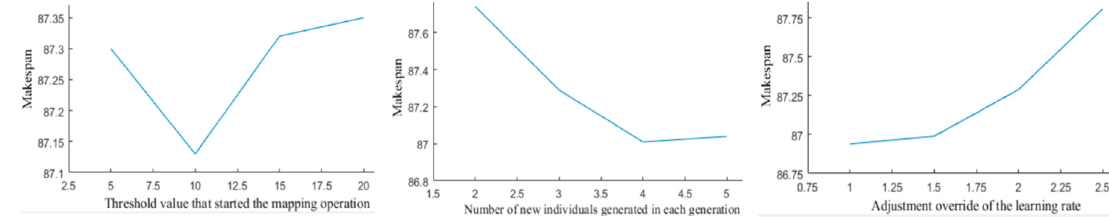
Figure 3. Trend chart of the algorithm’s performance impacted by each parameter.